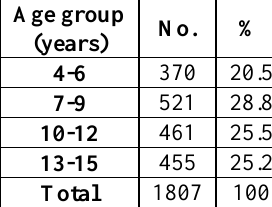
Table 2: Distribution of sample by age groups